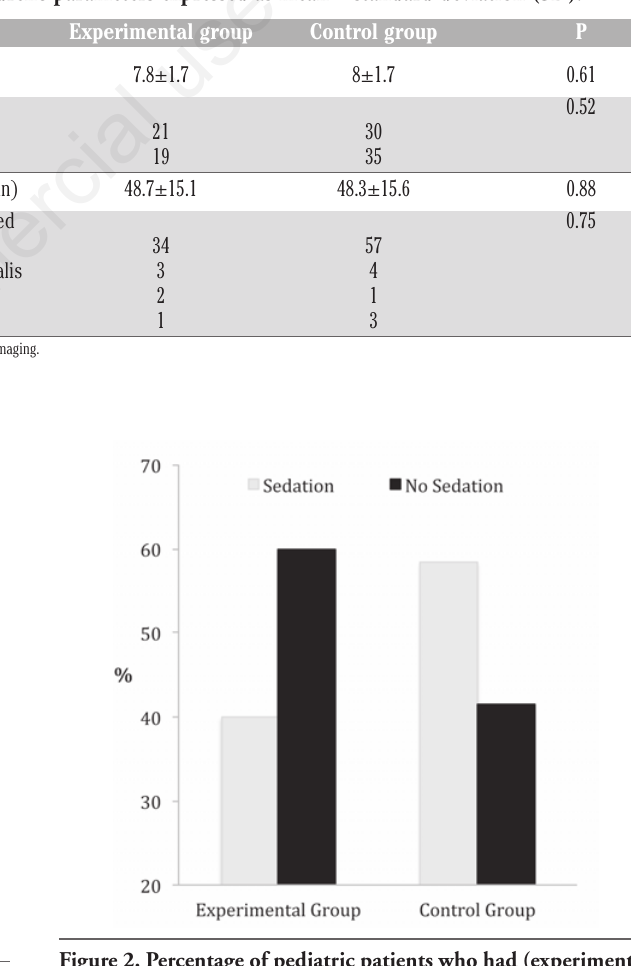
Table 1. The children’s parameters expressed as mean ± standard deviation (SD).